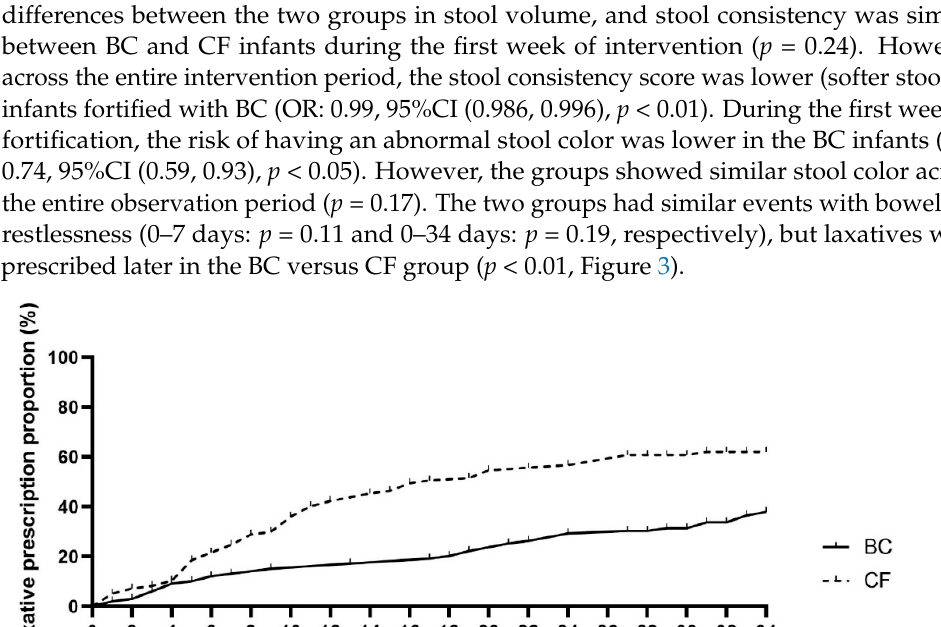
Figure 2. Mean volume of enteral nutrition per kg pr. day ( A ), and the proportion of the mother’s own milk (MOM) per meal ( B ) for Bovine colostrum (BC) and Conventional fortifier (CF). pr.: per. * p < 0.05